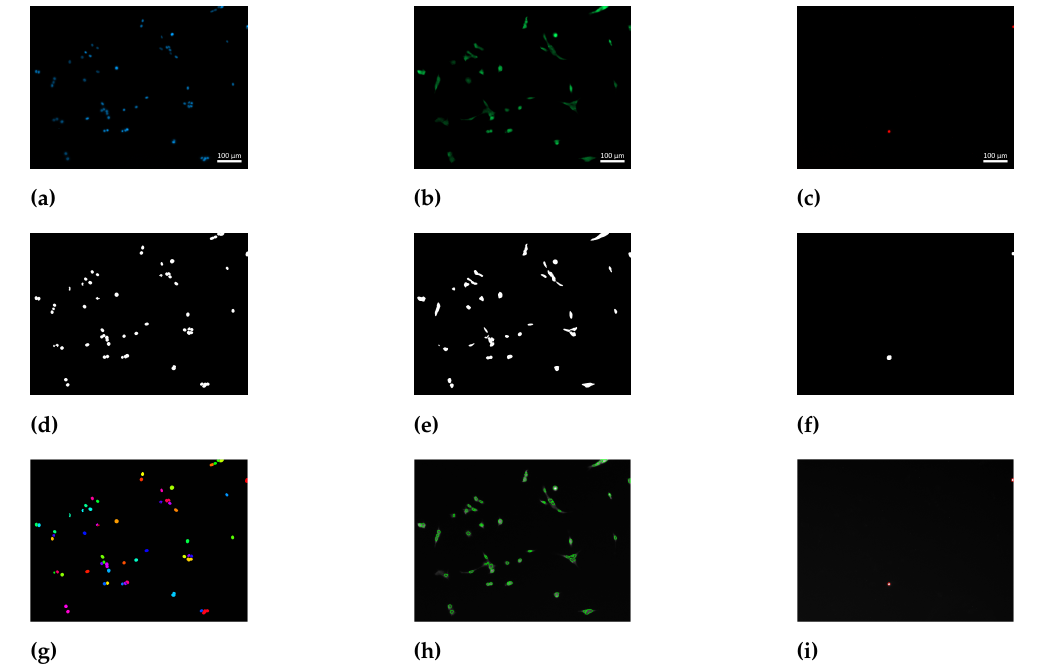
Figure 2. Image processing workflow for cell counting. ( a – c ) Single signal images used as inputs for the image processing workflow. Scale bar: 100 µm. ( a ) Nuclear DNA stained using membrane- permeable Hoechst 33342, ( b ) calcein-AM converted to calcein and retained in the cytoplasm, and ( c ) DNA stained using membrane-impermeable propidium iodide. The input images are preprocessed to binary data. ( d – f ) Resulting binary images of the regions of interest. ( d ) Nuclear region within all cells, ( e ) cytoplasmic region within viable cells, and ( f ) nuclear region within dead cells. ( g ) Single nuclear regions are identified with a watershed segmentation algorithm. The identified nuclei behind the produced mask from the calcein stain are considered viable, whereas nuclei behind the mask from the propidium iodide stain are considered dead cells. ( h ) Outline of nuclei of cells identified as viable shown in green as a composite with the raw image. ( i ) Outline of nuclei of cells identified as dead shown in red as a composite with the raw